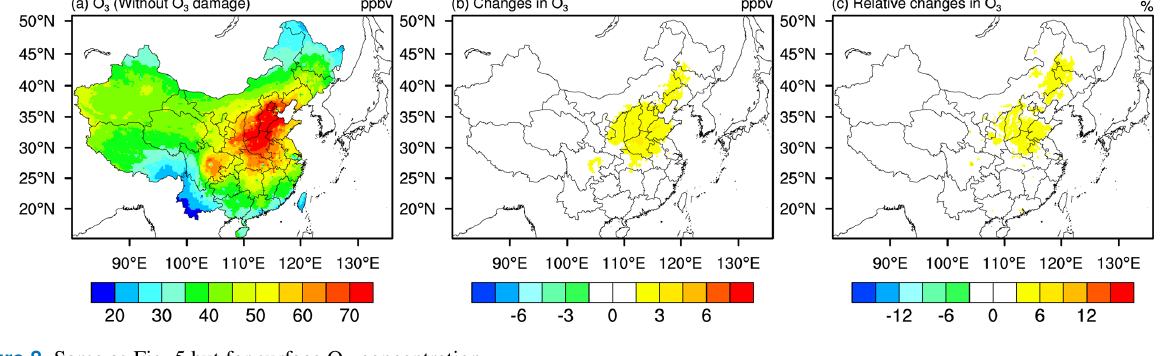
Figure 8. Same as Fig. 5 but for surface O 3